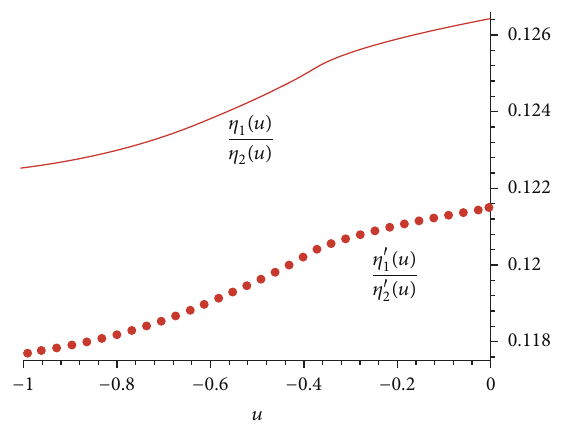
Figure 6: The graph of functions 𝜂 1 (𝑢)/𝜂 2 (𝑢) and 𝜂 󸀠 1 (𝑢)/𝜂 󸀠 2 (𝑢) on the interval (−1,0) are, respectively, plotted in solid line and point